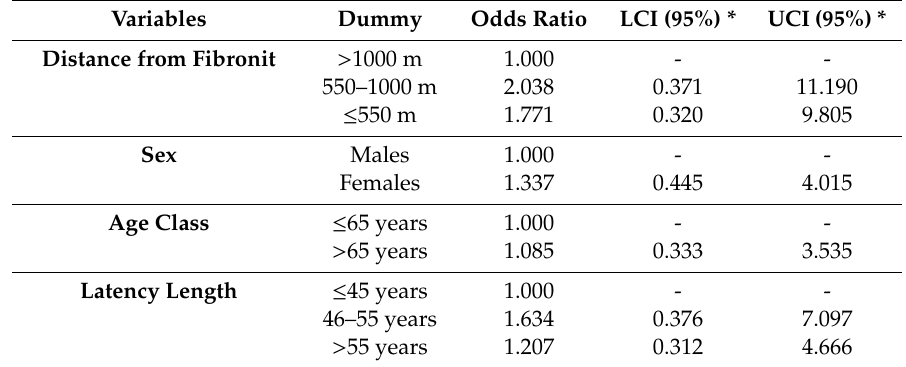
Table 8. Adjusted risks (ORs) of epithelioid mesothelioma by distance from Fibronit and latency length. Variables Dummy Odds Ratio LCI (95%) * UCI (95%) * Distance from Fibronit > 1000 m 1.000 - - 550–1000 m 2.038 0.371 11.190 ≤ 550 m 1.771 0.320 Sex Males 1.000 - - Females